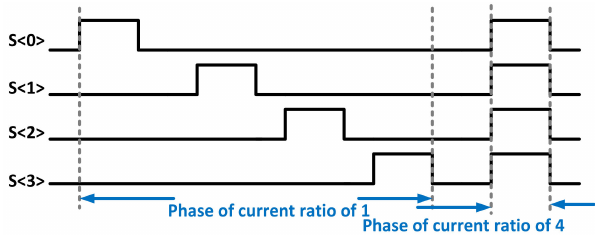
Figure 3. The dynamic element matching (DEM)’s timing